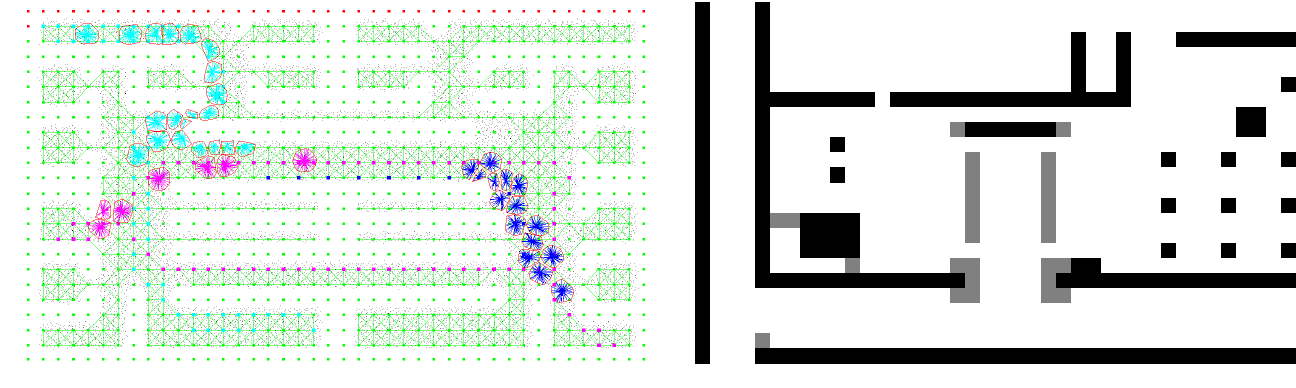
Fig. 19. Snack bar scenario without avoidance nodes for the